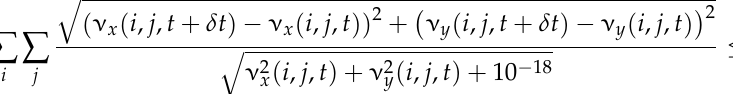
Table 1. The physical properties and boundary condition of flow model .